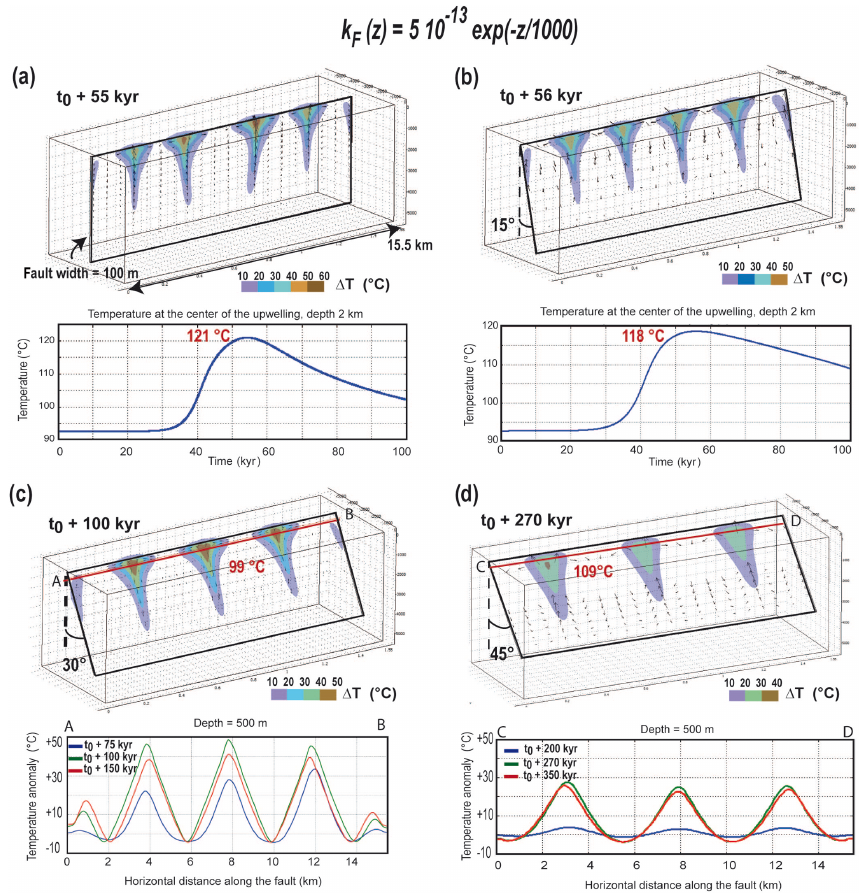
Figure 11. Experiments with a longer (15.5km long) fault with different dip angles (0, 15, 30, and 45 ◦ ). Permeability is depth-dependent with a maximum value of 5 × 10 − 13 m 2 for each case. The obtained temperature anomalies slightly exceed 50 ◦ C in the vertical case only. Cross sections illustrate the maximum temperature anomaly obtained during the entire experiment. The time evolution of temperature (top) or temperature anomalies (bottom) is shown beneath the temperature anomaly